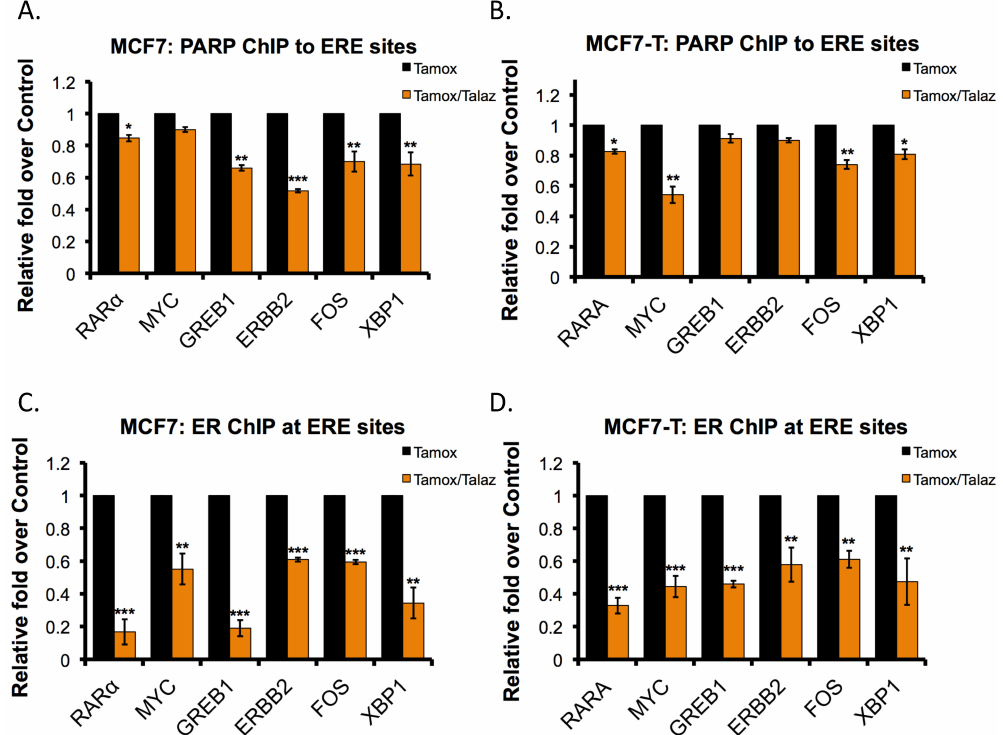
Figure 4. Talazoparib decreases PARP1 and ER α localization to ER α -target genes. Chromatin immunoprecipitation (ChIP) analysis of PARP1 localization to ER α -target genes (RARA, MYC, GREB1, ERBB2, FOS, XBP1) was performed in ( A ) MCF7 or ( B ) MCF7-T cells following tamoxifen treatment (Tamox; 100 nM) with or without talazoparib (Talaz; 1 nM). Chromatin immunoprecipitation (ChIP) analysis of ER α localization to ER α -target genes (RARA, MYC, GREB1, ERBB2, FOS, XBP1) was performed in ( C ) MCF7 or ( D ) MCF7-T cells following Tamox treatment (100 nM) with or without 1 nM Talaz. * p < 0.01, ** p < 0.001, *** p < 0.0001 compared to